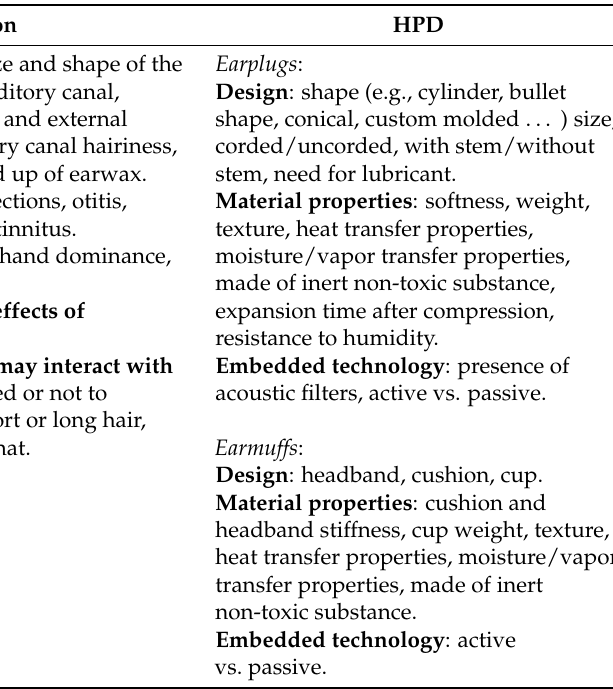
Table 4. Physical characteristics of the triad “environment/person/HPD”.